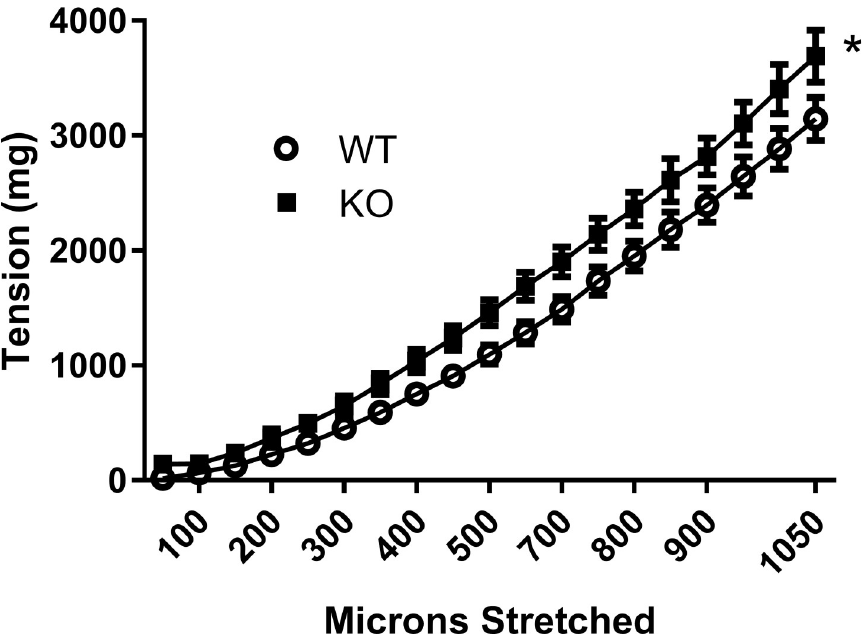
Fig 5. Length-tension relationship for aorta from wild-type (WT) and Slc29a1-null (KO) mice. Tissues were incubated for 30 min at 22˚C in KPSS buffer with no resting tension, prior to increasing tension in 50 micron increments. Each point represents the mean ± SEM, N = 7. � Significant difference between aortas from wild-type and Slc29a1 -null mice (Two-Way ANOVA for unpaired experimental parameters, P < 0.05).